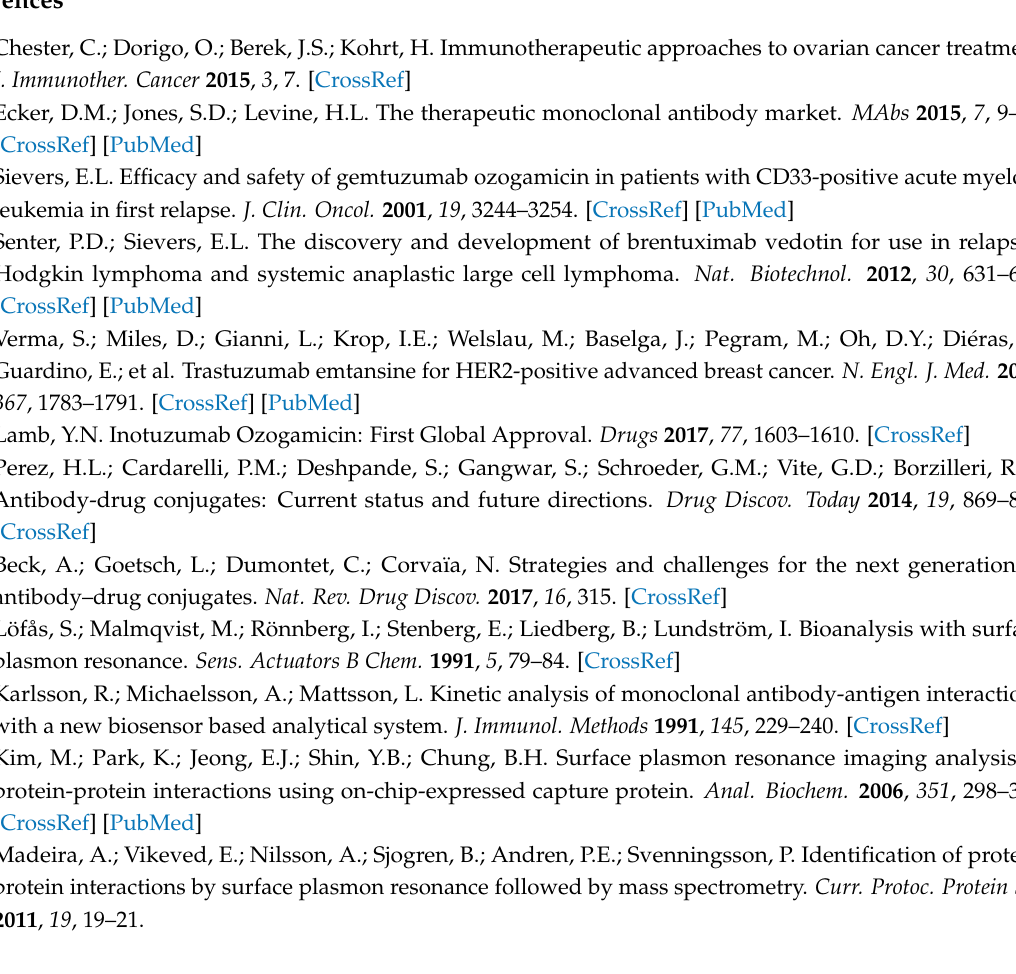
Figure S1: Linkers used during ADC manufacture, title, Figure S2: RAGE antibody binding locations, Figure S3: PLRP traces of high and low DAR ADCs, Figure S4: ELISA of BSA conjugated